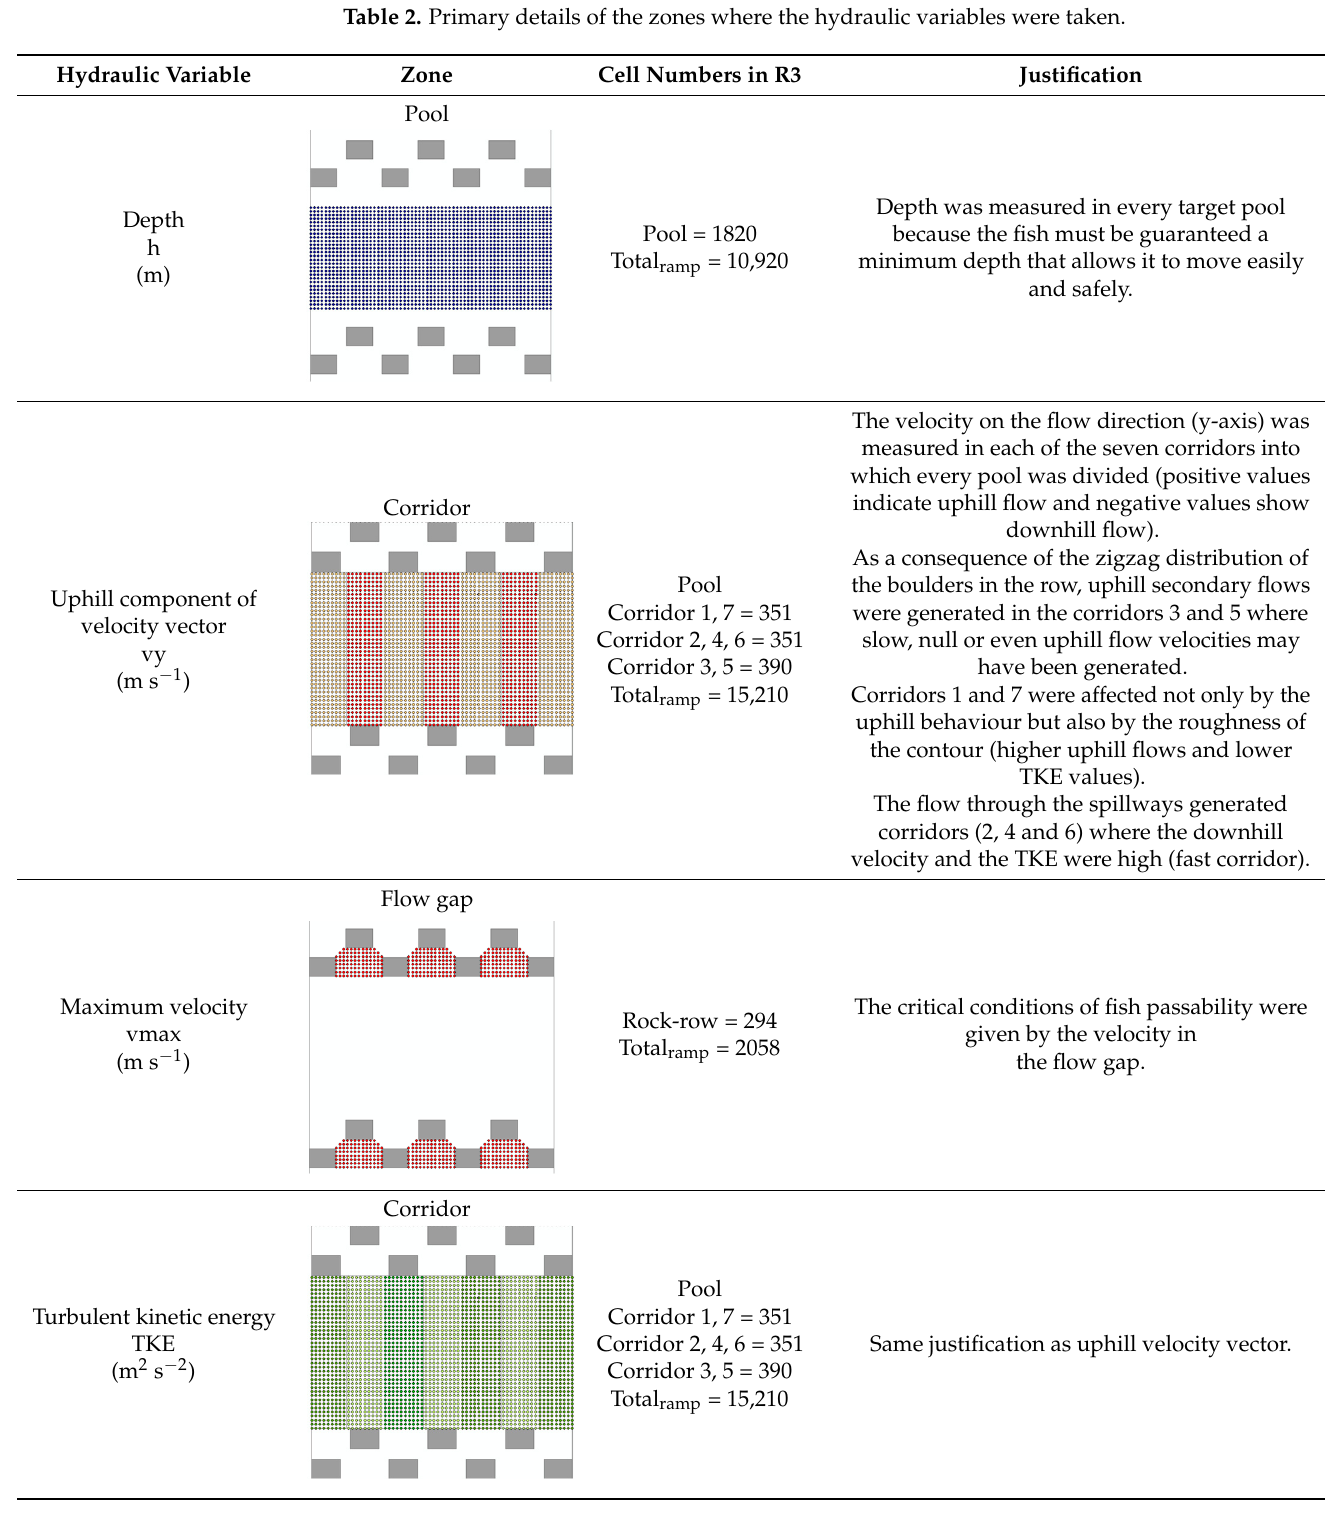
Table 2. Primary details of the zones where the hydraulic variables were